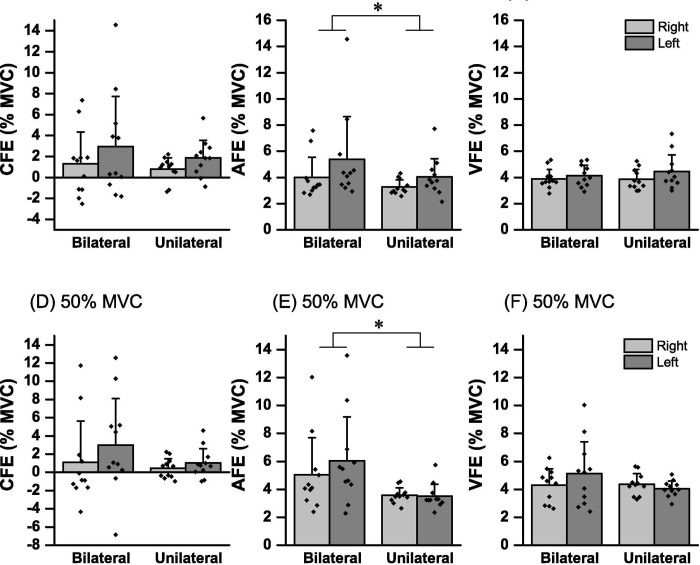
Mean force intensity errors in right- (gray bar) and left-hand (dark gray bar) for bilateral and unilateral contractions.Dot presents the value for each individual. (A) constant force error (CFE) of 30% of maximal voluntary contraction (MVC) target, (B) absolute force error (AFE) of 30% of MVC target, (C) variable force error (VFE) of 30% of MVC target, (D) CFE of 50% of MVC target, (E) AFE of 50% of MVC target, and (F) VFE of 50% of MVC target. * show main effect (p < 0.05).